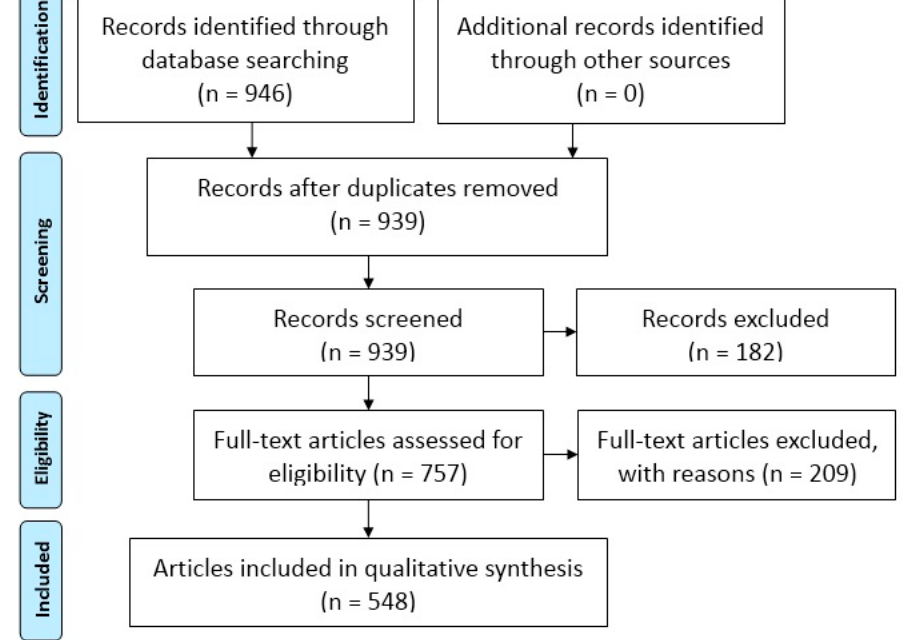
Figure 1. PRISMA flow diagram for this Systematic Literature